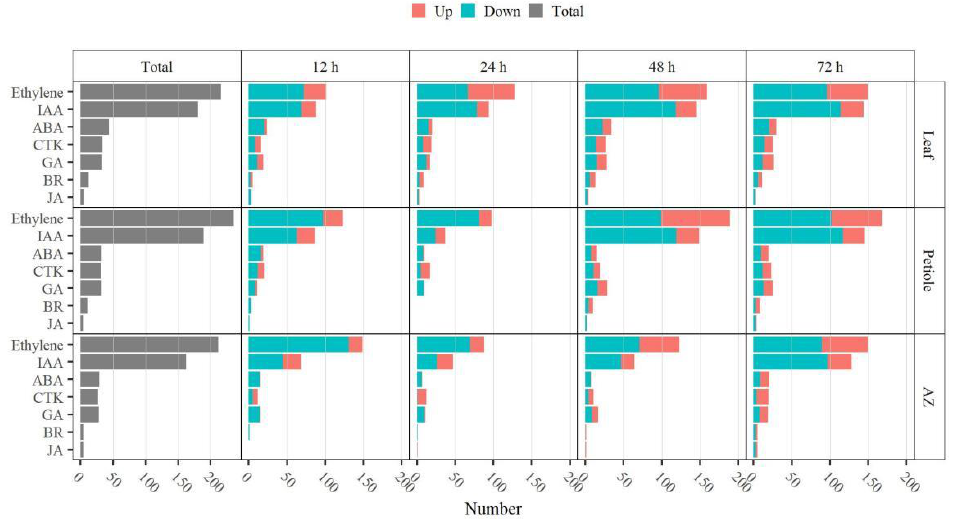
Figure 5. TDZ regulates the expression of phytohormone-related genes. The total number of up- and down-regulated DEGs related to plant hormones in leaf, petiole, and AZ at indicated time points after TDZ treatment were shown. DEGs were determined between 12 h and 0 h, 24 h and 0 h, 48 h and 0 h, 72 h and 0 h, respectively. The DEGs were controlled by FDR<5% and |log2Fc|≥1. Next, we analyzed the dynamic expression patterns of DEGs related to plant